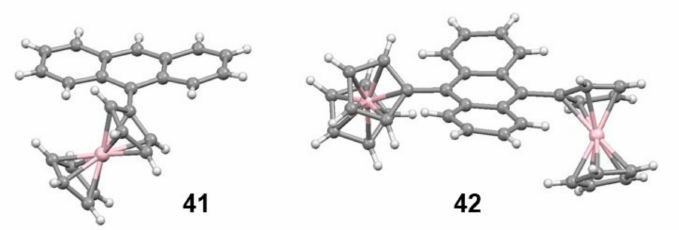
Figure 18. Structures of 9-ferrocenylanthracene, 41 , and 9,10-diferrocenylanthracene, 42 .